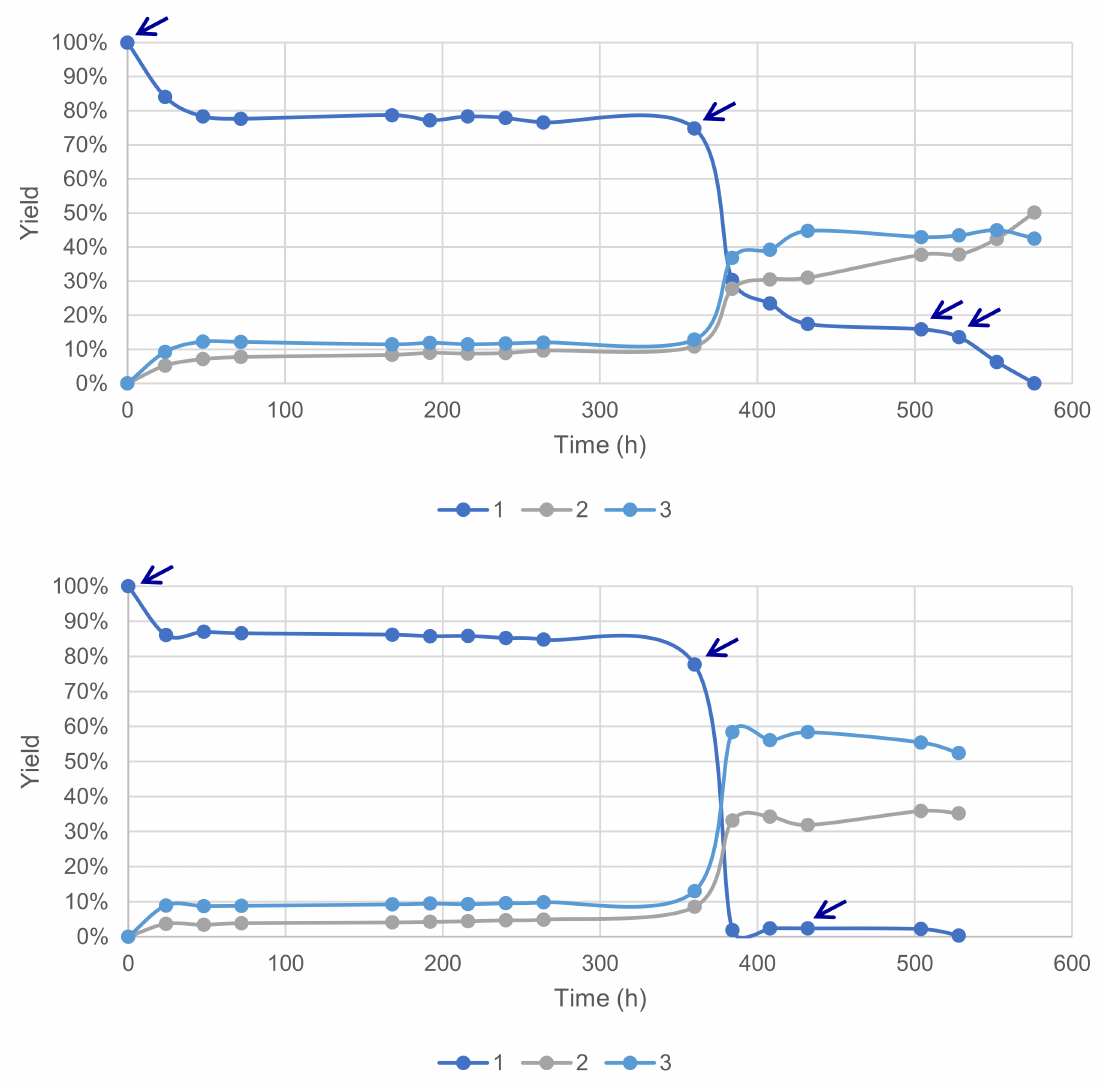
Figure 11. Sequential supply of fresh enzymes ( top ) and the mediator ( bottom ) marked with arrows for each addition of material (acetate buffer pH5, 6 mmol substrate 1 0.12 M, O 2 atmosphere, 40 ◦ C, magnetic